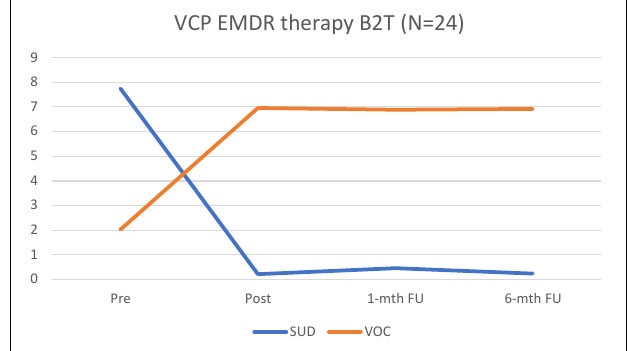
FIGURE 1 | Alterations in SUD and VOC scores at pre, post, 1-month, and 6-month